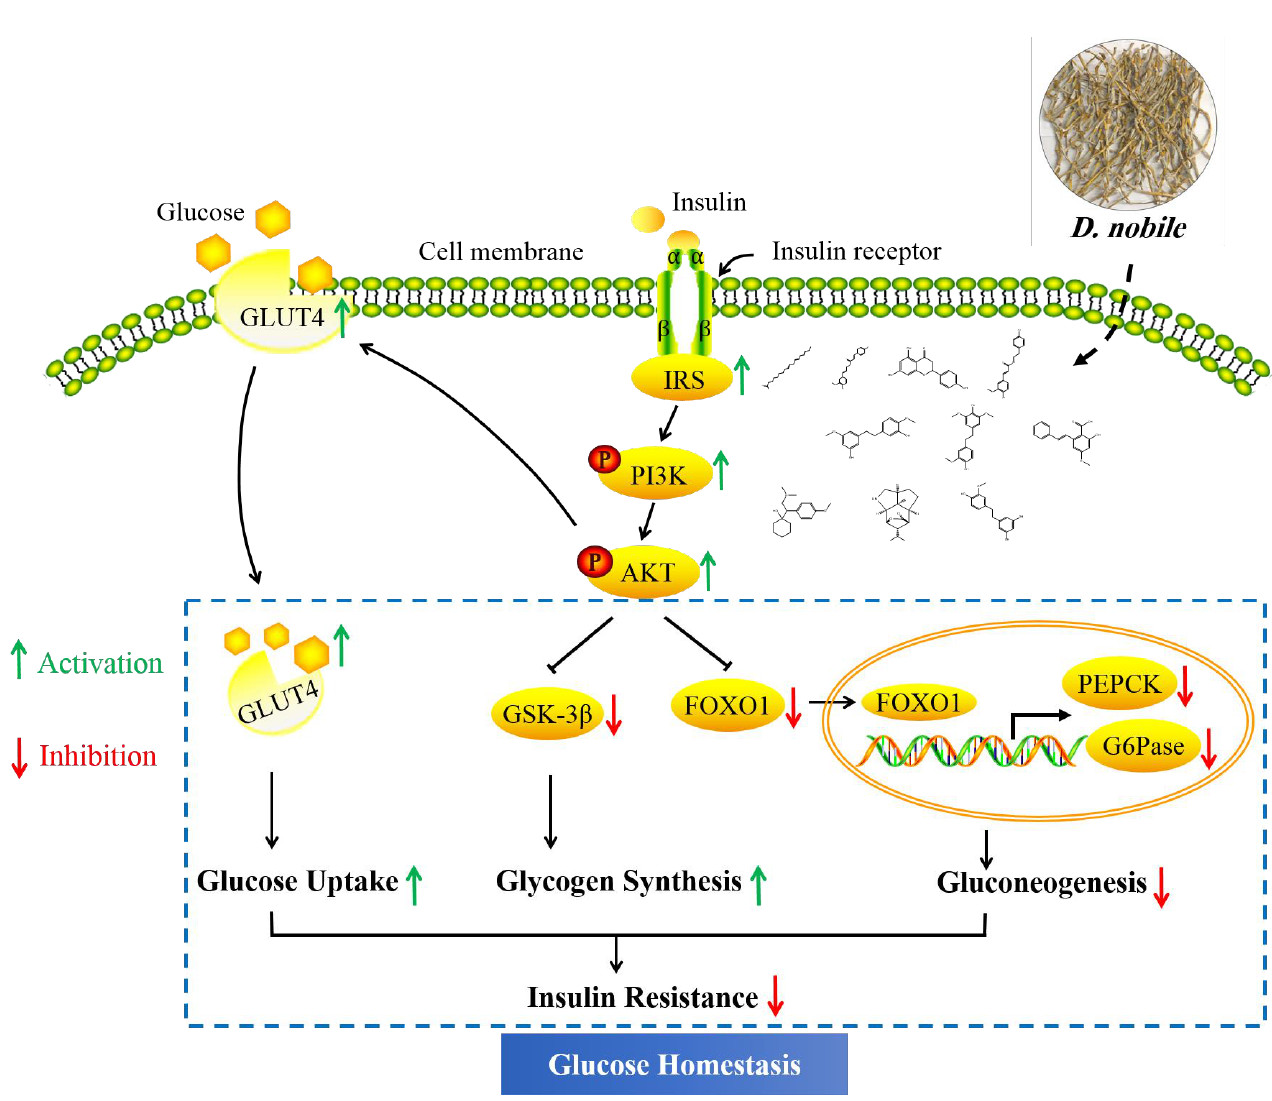
Figure 19. The hypoglycemic mechanism of D. nobile in the treatment of T2DM rats.